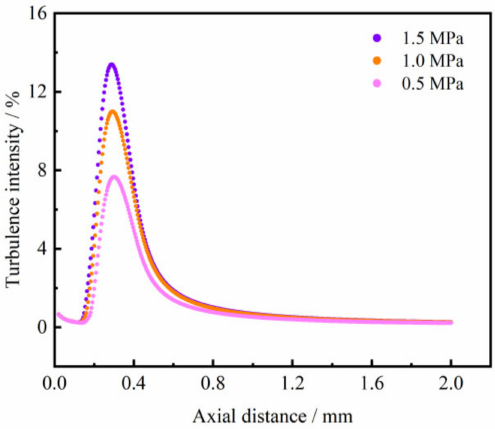
Figure 9. Particle mass concentration distribution at different pressure differences.